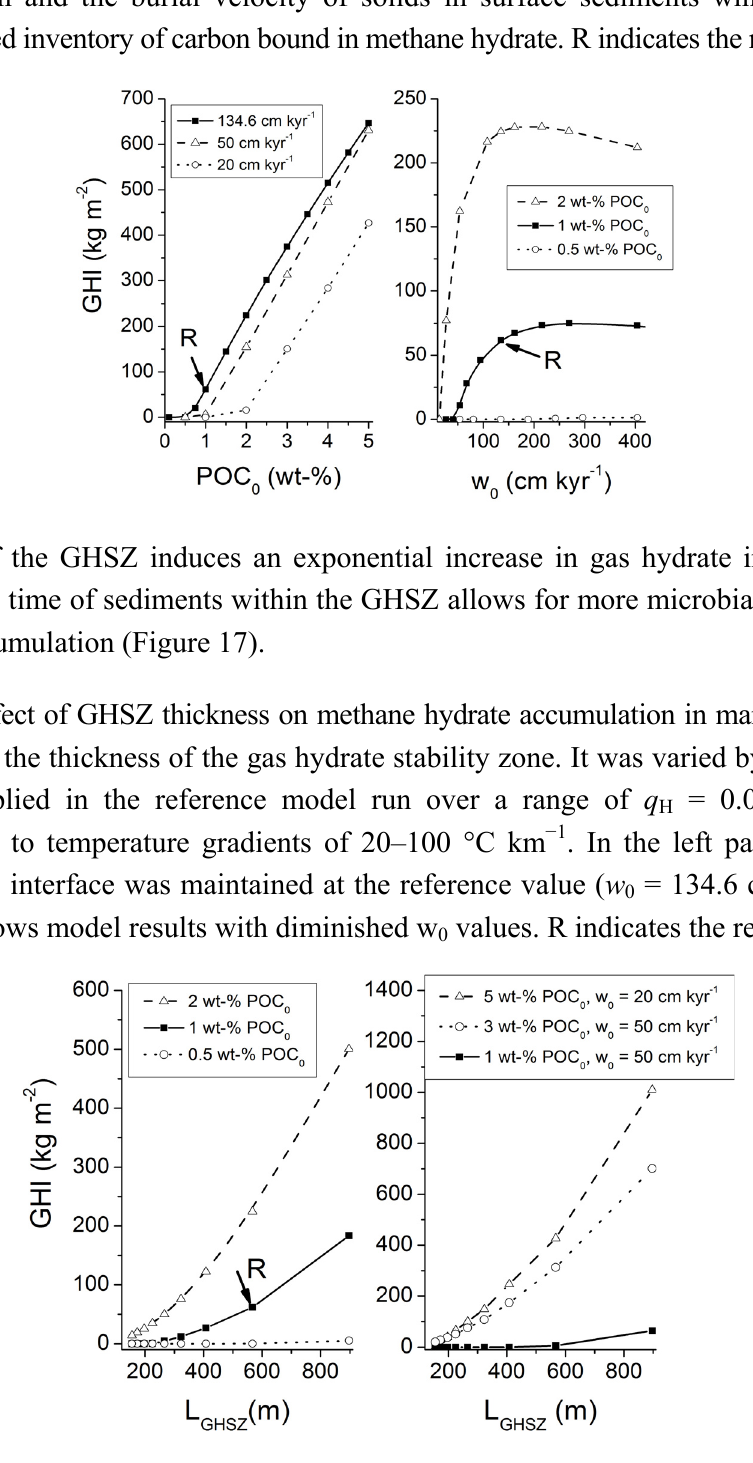
Figure 16. Effect of POC concentration and burial velocity on methane hydrate and w are the concentration of particulate accumulation in marine sediments. POC 0 0 organic carbon and the burial velocity of solids in surface sediments while GHI is the depth-integrated inventory of carbon bound in methane hydrate. R indicates the reference case.